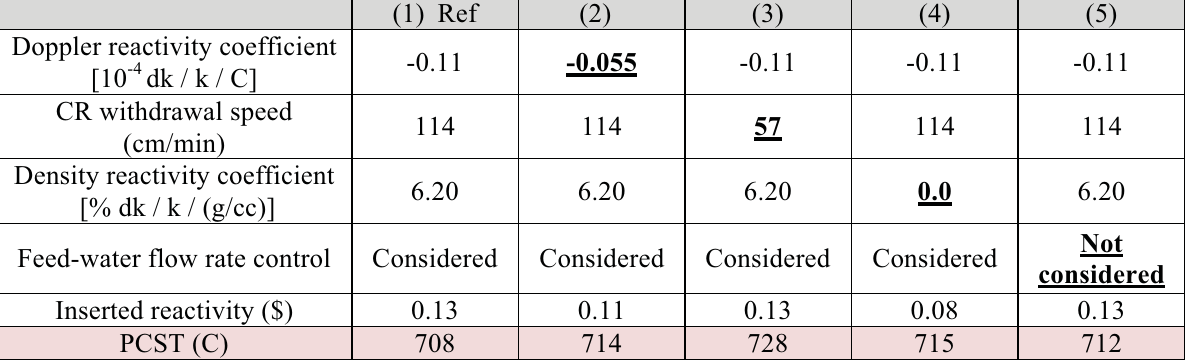
Figure 3: Plant behavior during uncontrolled Figure 4: Sensitivity of the Doppler reactivity (cid:2)(cid:2) (cid:2) withdrawal of CR coefficients on PCST Table II: Summary of sensitivity analyses for uncontrolled CR withdrawal at full